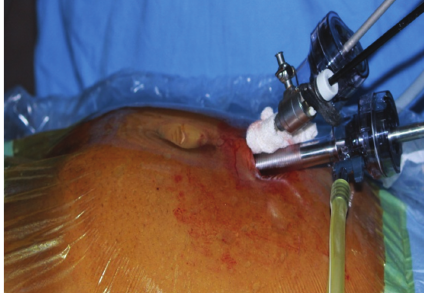
Figure 4: Clipping of the renal